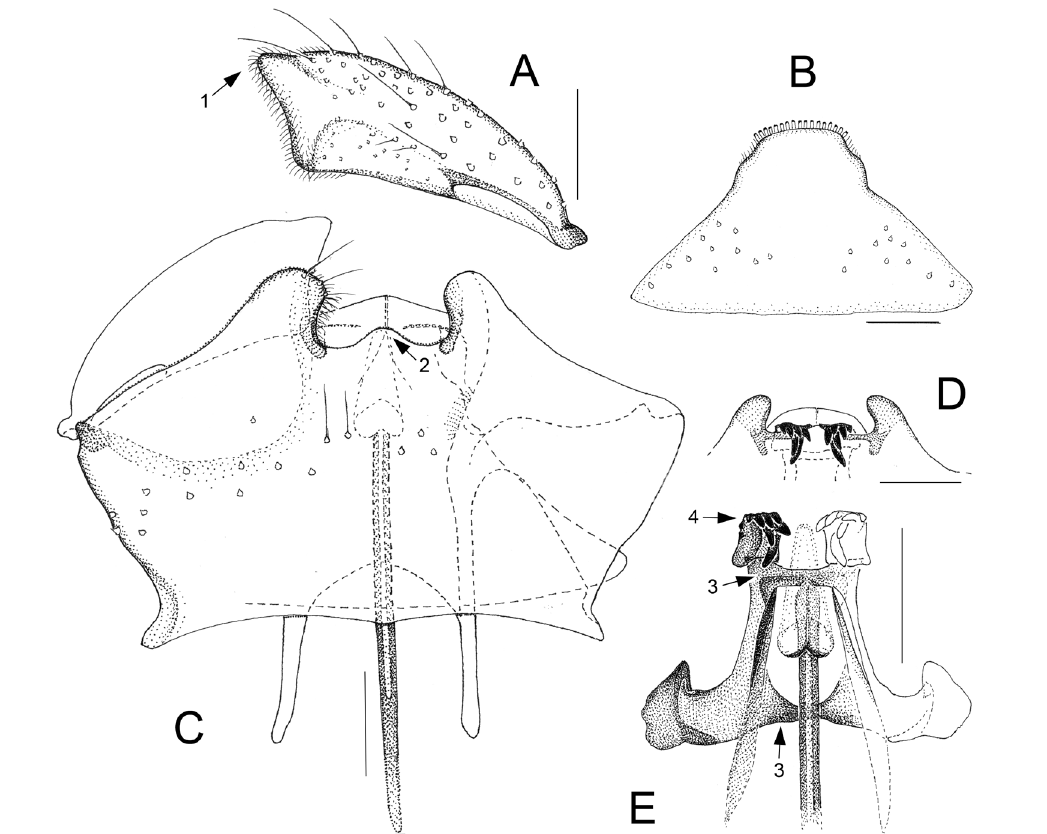
Fig. 18. Glemparon waipoua sp. nov., holotype, ♂ (NZAC, no. CEC1412) (A–C, E) and possibly closely related species (D). A . Gonostylus, lateral. B . Ninth tergite, dorsal. C . Genitalia, ventral. D . Ventroposterior edge of gonocoxites and tegminal processes, ventral. E . Apex of ejaculatory apodeme and tegmen, ventral. Scale bars = 0.05 mm. Numbered arrows indicate diagnostic characters (see